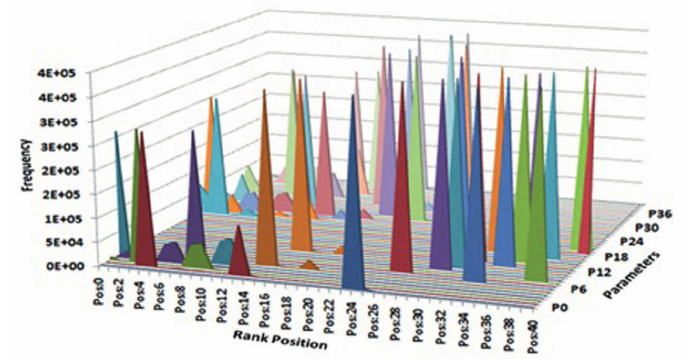
Figure 2. Rank frequency for 41 parameters for objects in class 2.